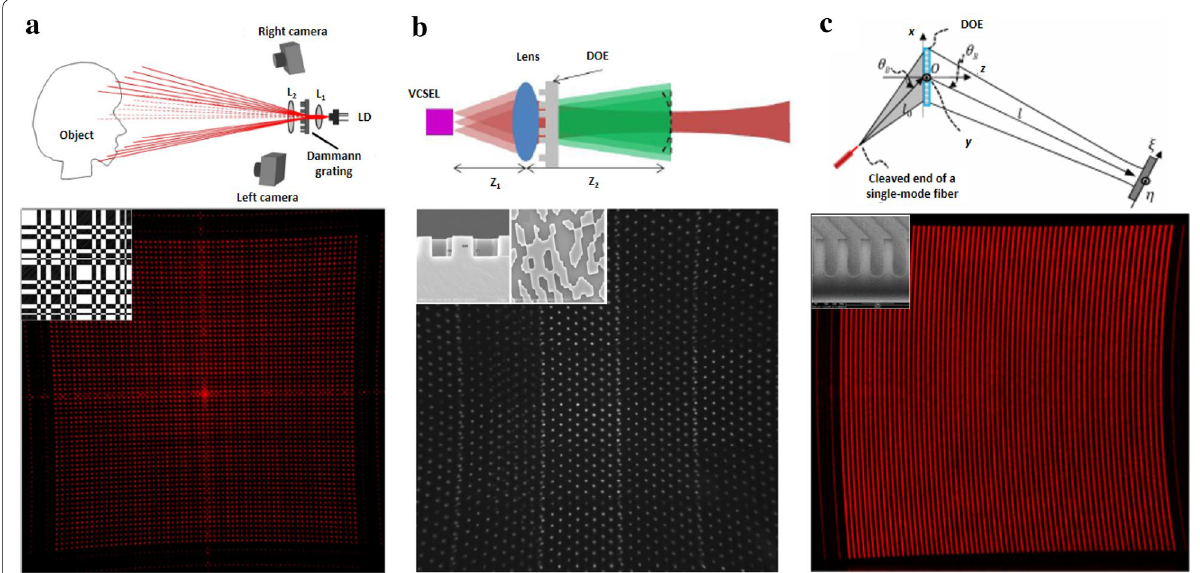
Fig. 4 Structured light system by diffraction generation from laser transmission through grating structures; a binocular 3D imaging system using a structured light projector with a Dammann grating and captured diffraction patterns by a designed Dammann grating (inset) [35, 36]. b Structured light projector with a DOE designed by the Gerchberg–Saxton algorithm and patterned VCSEL arrays. Their projected dot array pattern is shown at the bottom line with fabricated DOE (inset) [37]. c Multifunctional binary DOE in combination with diffractive lens, Gaussian‑to‑tophat beam shaper, and Dammann grating. Their projected tophat line array pattern is shown at the bottom line with fabricated DOE (inset)